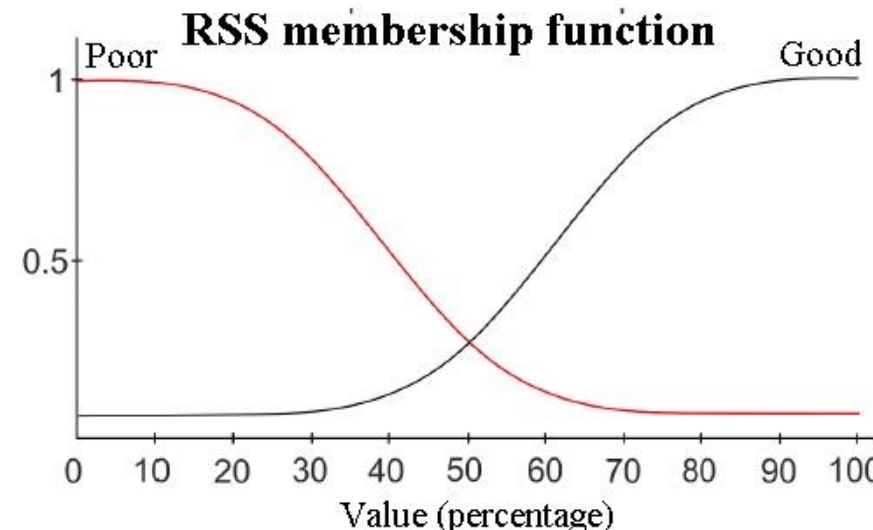
Figure 9. Really Simple Syndication (RSS) membership function.